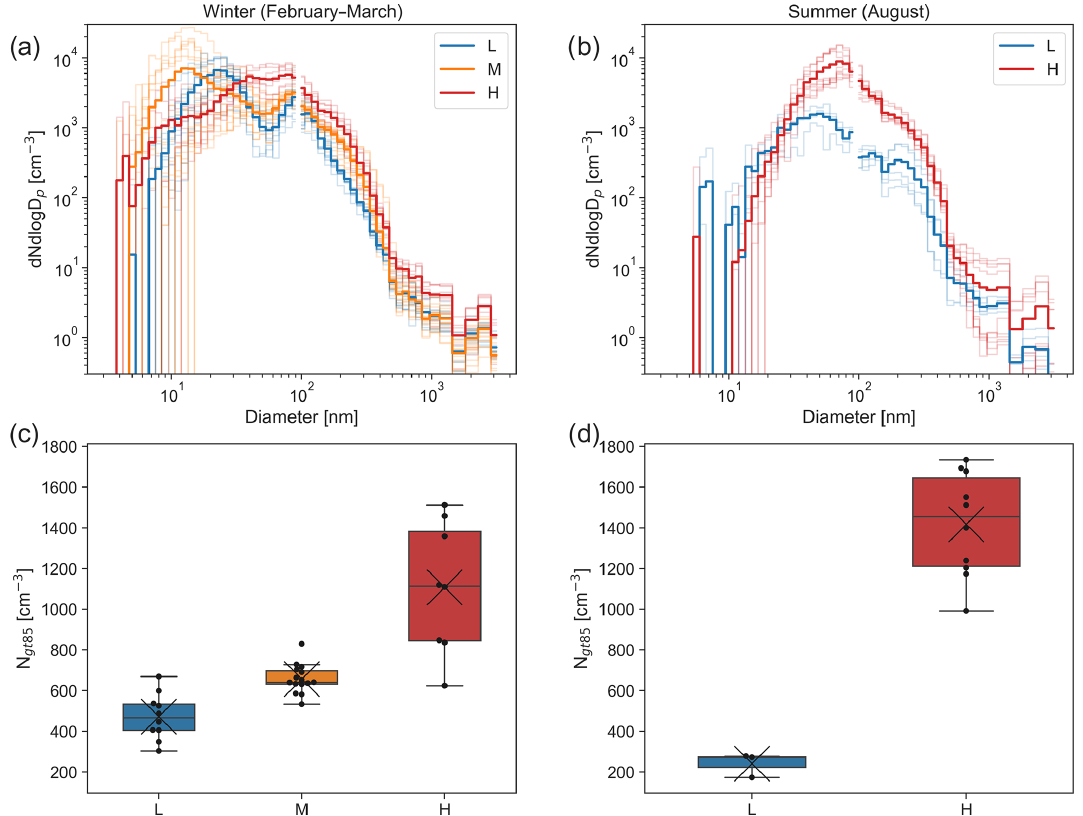
Figure 5. Wintertime aerosol size distributions from the SMPS–LAS instrument combination of the low (P/blue), medium (M/orange) and high (H/red) N CCN group with their mean distribution and shaded distributions for a single pair (a) . The same is done in (b) for the 0 . 43% summertime aerosol size distribution of the L and H group. Whisker plots of N gt85 with the mean marked by a cross for wintertime (c) and summertime (d) . No summertime pair is attributable to the M group and is thus not shown in (b) and (d)